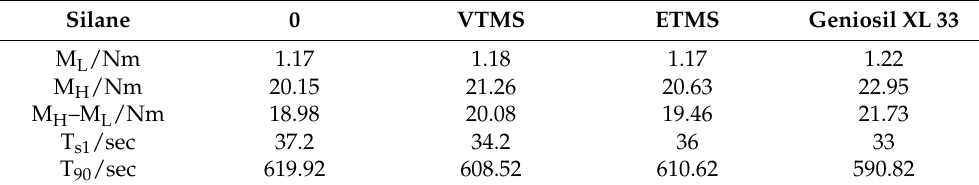
Table 2. Rheometer parameters of the EPDM/CaCO 3 composites.